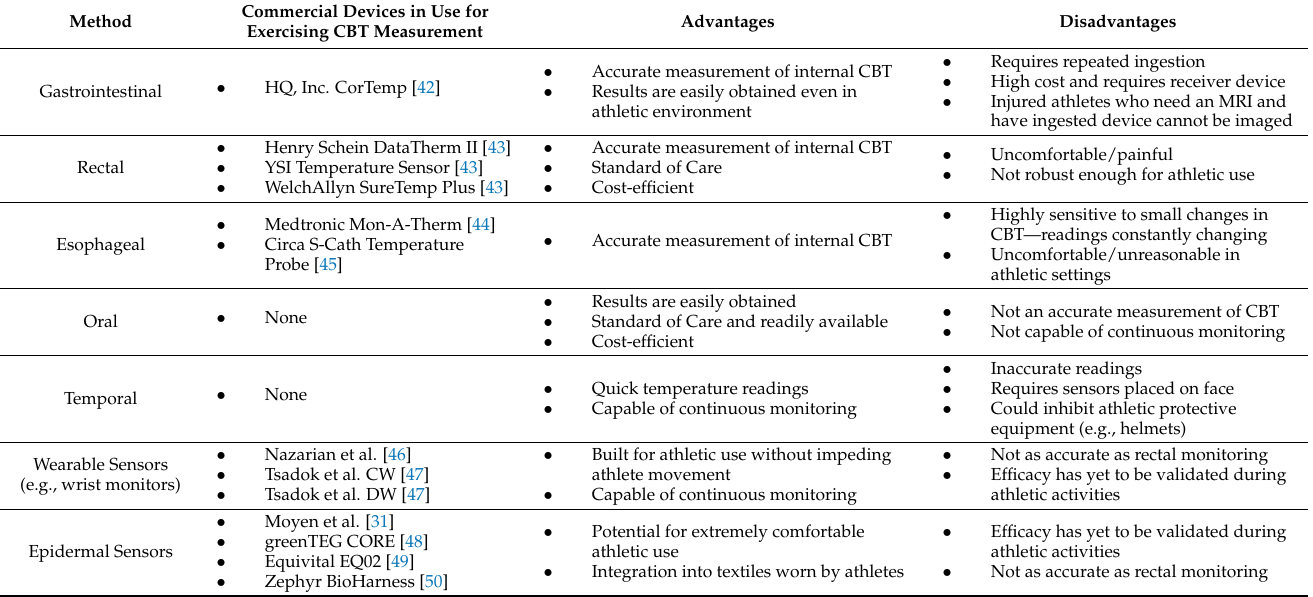
Table 1. Comparison of methods used to measure CBT in exercising subjects. Summarized from reference [30]. Commercial devices listed are only those marketed or validated as measuring exercising